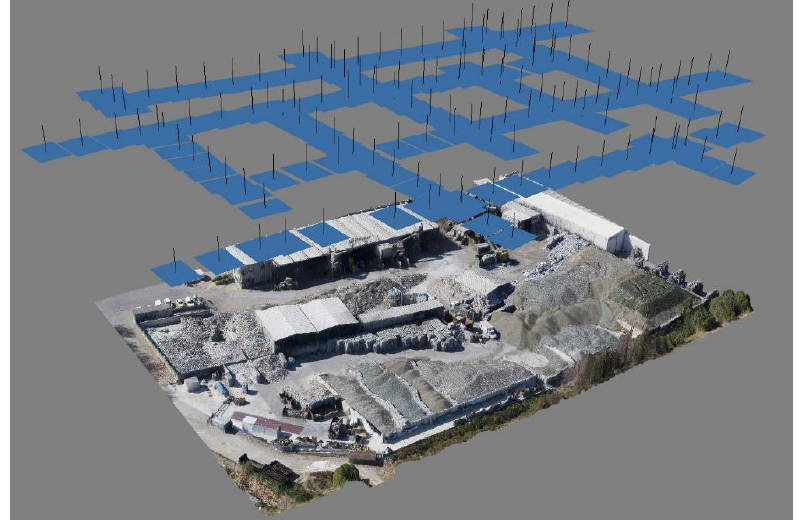
Figure 4. UAV survey of the waste stockpile area (vertical flight).